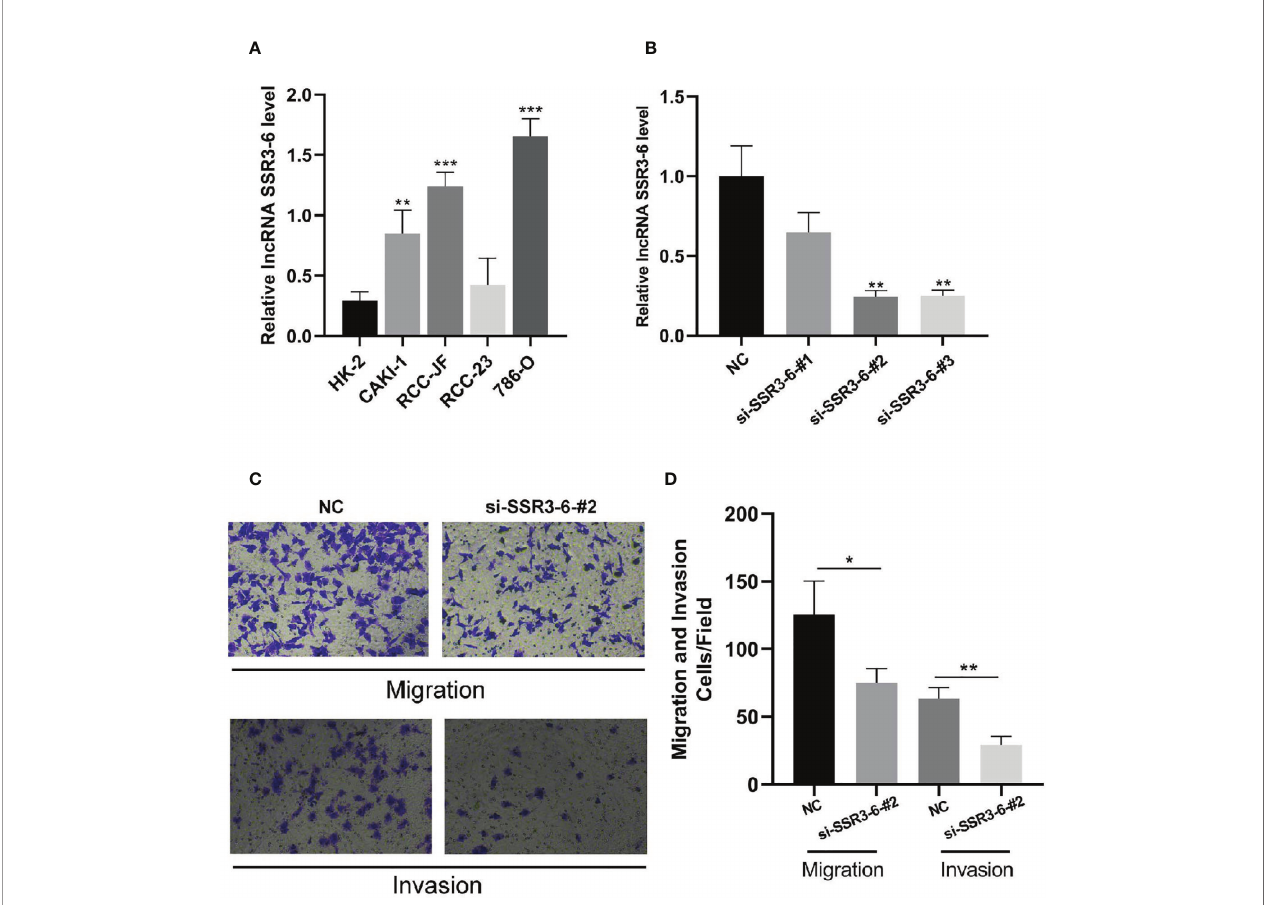
FIGURE 9 | Knockdown of SSR3-6 inhibits cell migration and invasion of 786-O cells. (A) We detected the expression of SSR3-6 in HK-2 cells and 4 kinds ccRCC cells. SSR3-6 expression levels were higher in all ccRCC cells than in HK-2, and 786-O was the highest. (B) We used siRNA technology to knock down SSR3-6 in 786- O and found that the knockdown effect of si-SSR3-6-2# sequence was the best. (C, D) To investigate the biological role of SSR3-6 in migration and invasion, transwell assays were performed. We found that the cell migration and invasion abilities were markedly decreased in the si-SSR3-6-2#, compared with the NC groups. *P < 0.05, **P < 0.01, ***P <